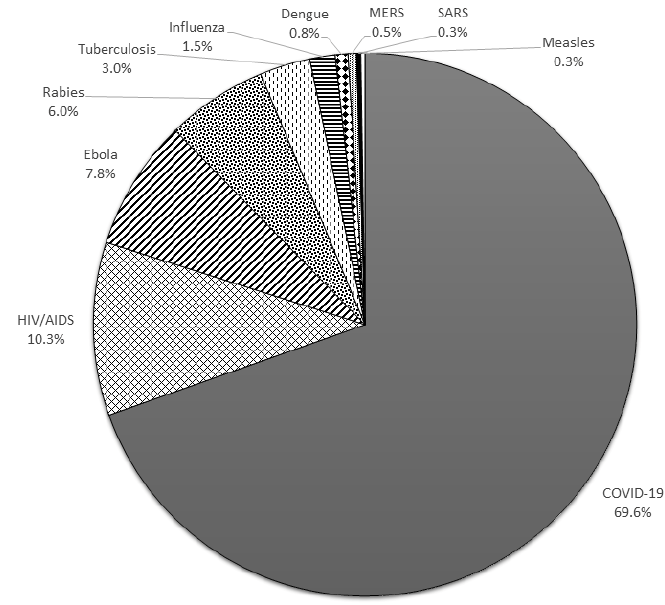
Figure 2. Most-feared infectious diseases among nursing care workers.